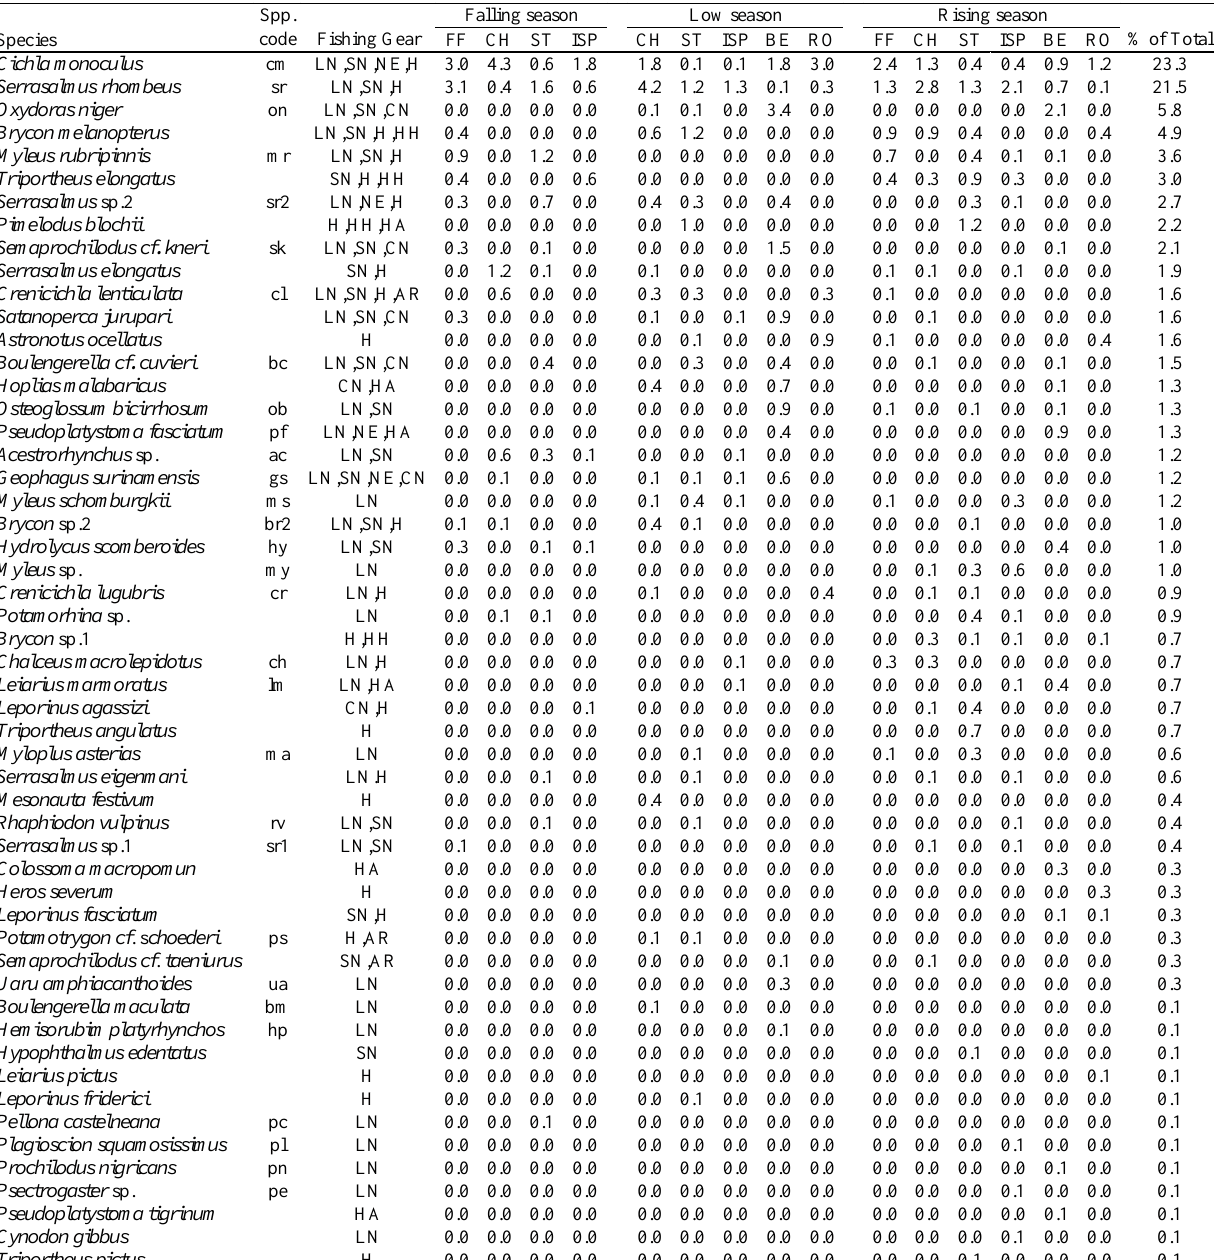
Table 3. Relative abundance (percentage of total number of individuals, n = 669), of 53 species captured in six habitats in Taraira Lake, during three seasons. Habitat abbreviations follow Table 2. Codes given for species included in CA. Other abbreviations: LN – long gill net; SN – short gill net; NE – net enclosure; CN – cast net; H – hook and line; HH – hanging hook; AR – arrow; HA – harpoon. Collection’s catalog numbers are provided by Correa